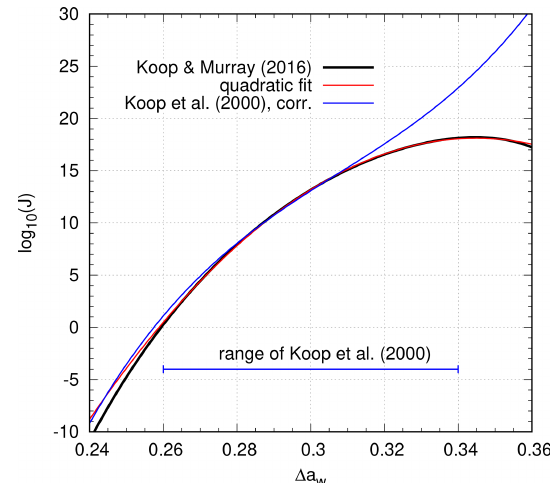
Figure 11. Freezing rate of water droplets (Koop and Murray, 2016, black), a polynomial fit (red), and the nucleation rate of solution droplets (Koop et al., 2000, corrected, blue), all depending on (cid:49)a w